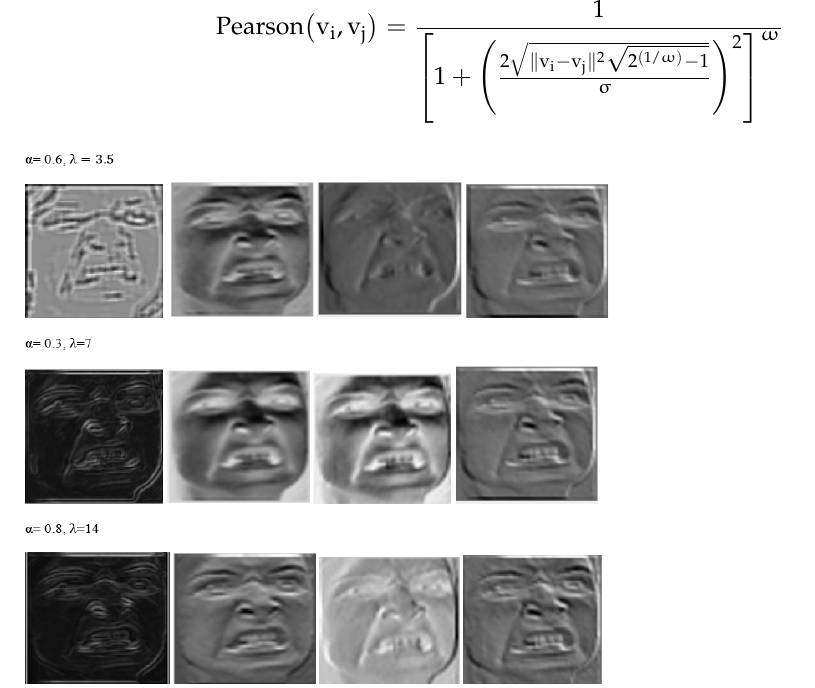
Figure 8. Outputs using two left-sided and two right-sided fractional order SMs and different values of α, λ